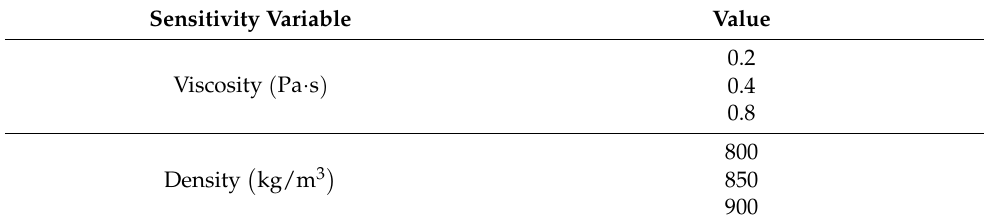
Table 4. Oil physical properties considered in the sensitivity